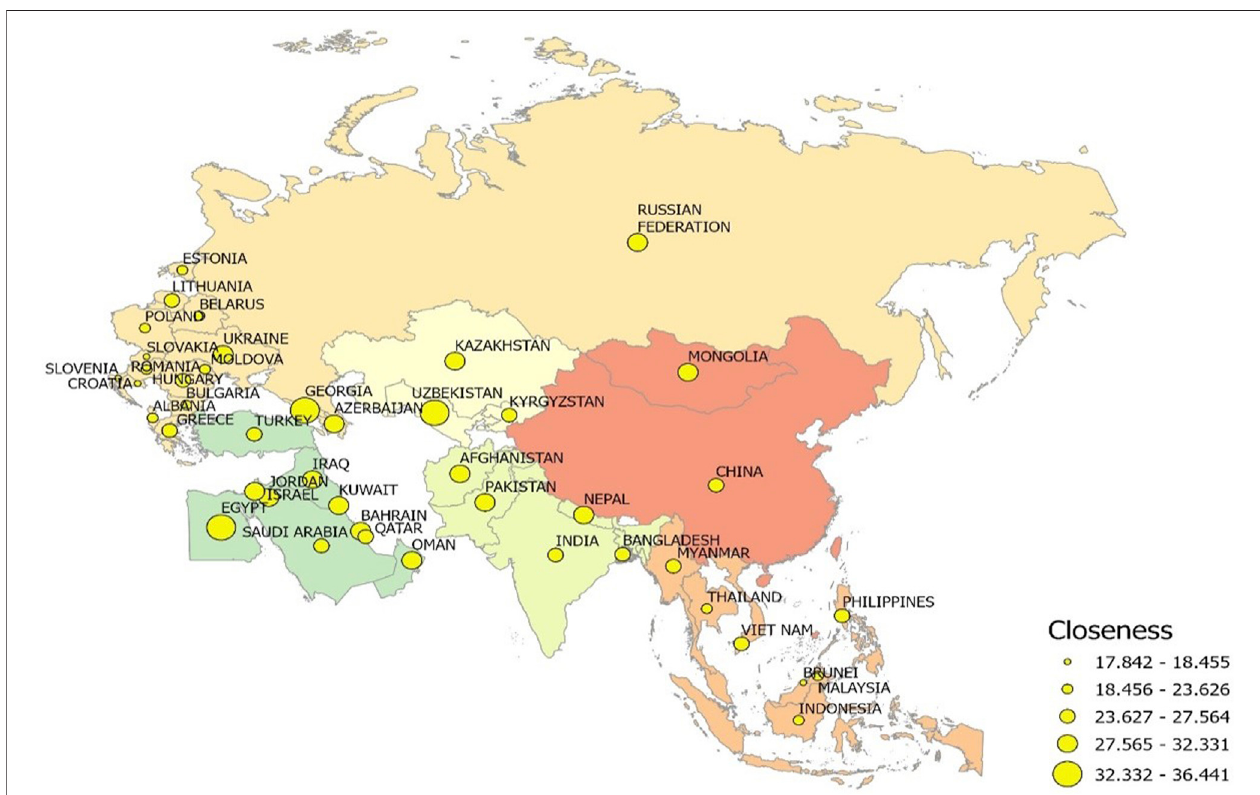
FIGURE 3 | Closeness of environmental risk in the